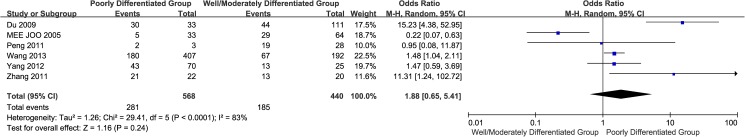
Meta-analysis of overexpression of EpCAM in poorly differentiated group and well/moderate differentiated group.